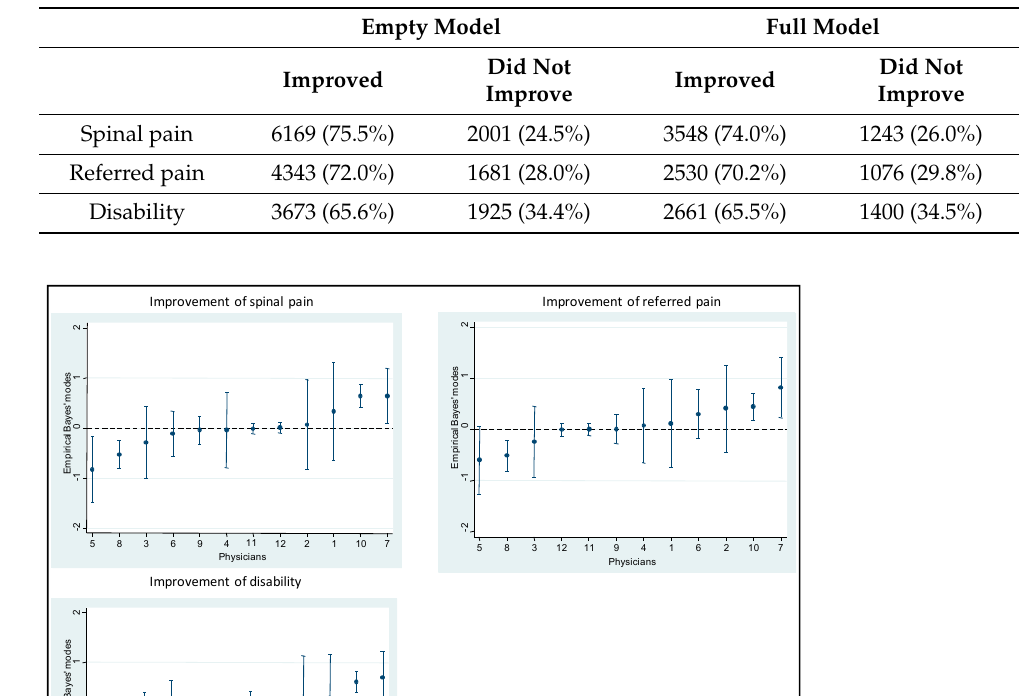
Table 9. Proportion of patients who improved and did not improve in the empty and full models.